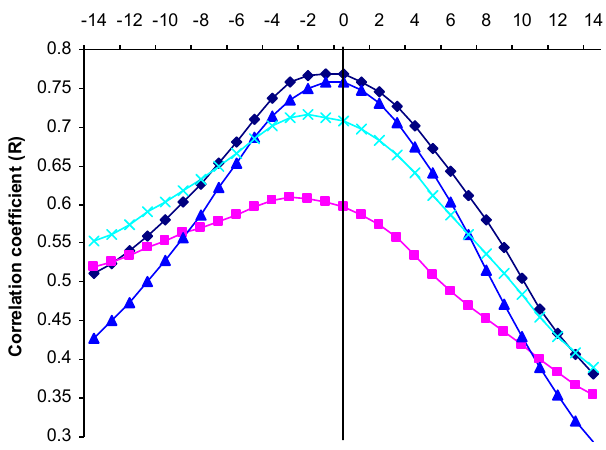
Figure 4. Correlograms of first-difference CO 2 with surface tem- perature for global (turquoise curve with crosses), tropical (blue curve with triangles), Northern Hemisphere (purple curve with boxes) and Southern Hemisphere (black curve with diamonds) cat-